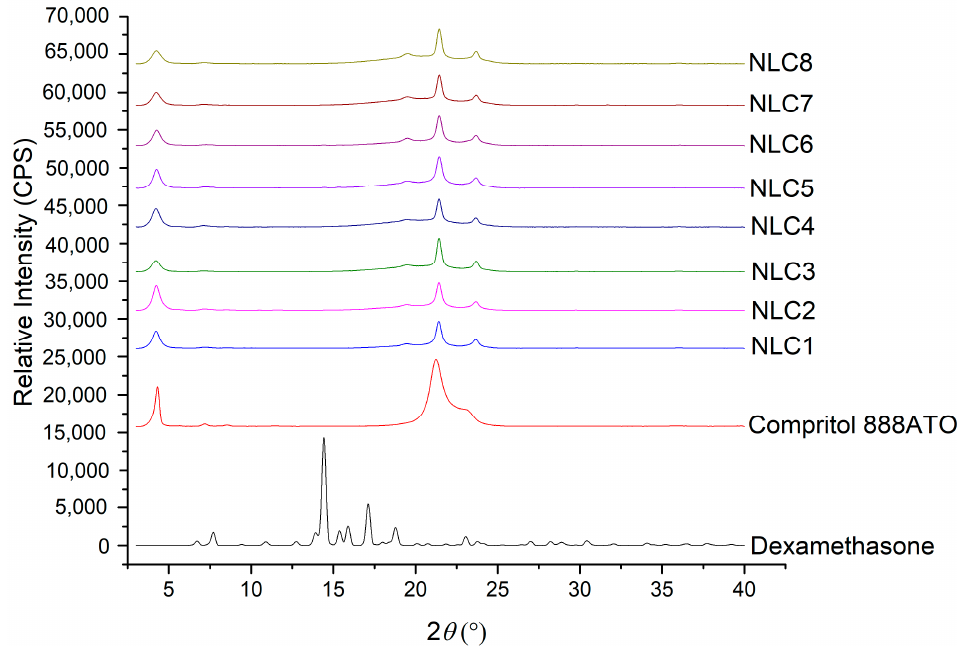
Figure 1. XRD di ff ractogram of the NLC1-8 compositions, Compritol 888 ATO and Figure 1. XRD diffractogram of the NLC1-8 compositions, Compritol 888 ATO and DXM.